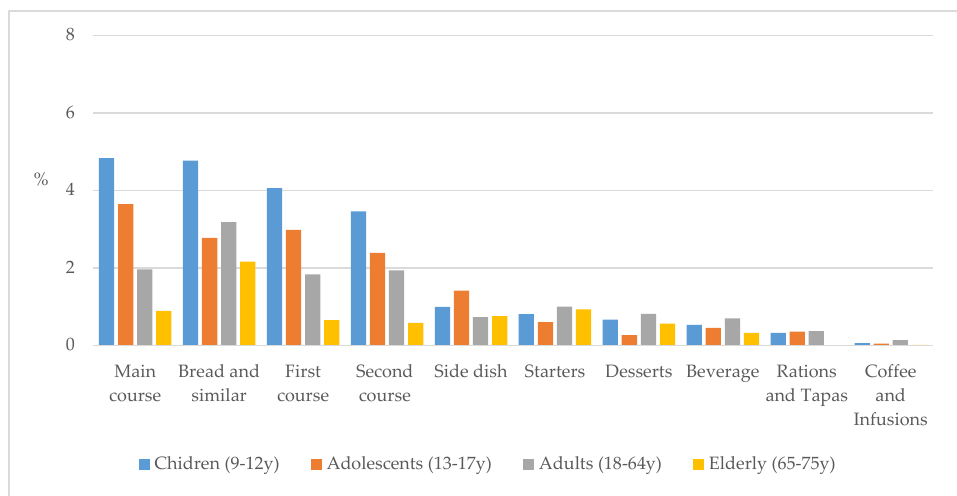
Figure 4. Percentage of plate waste across different menu components consumed by age groups from the ANIBES study population.